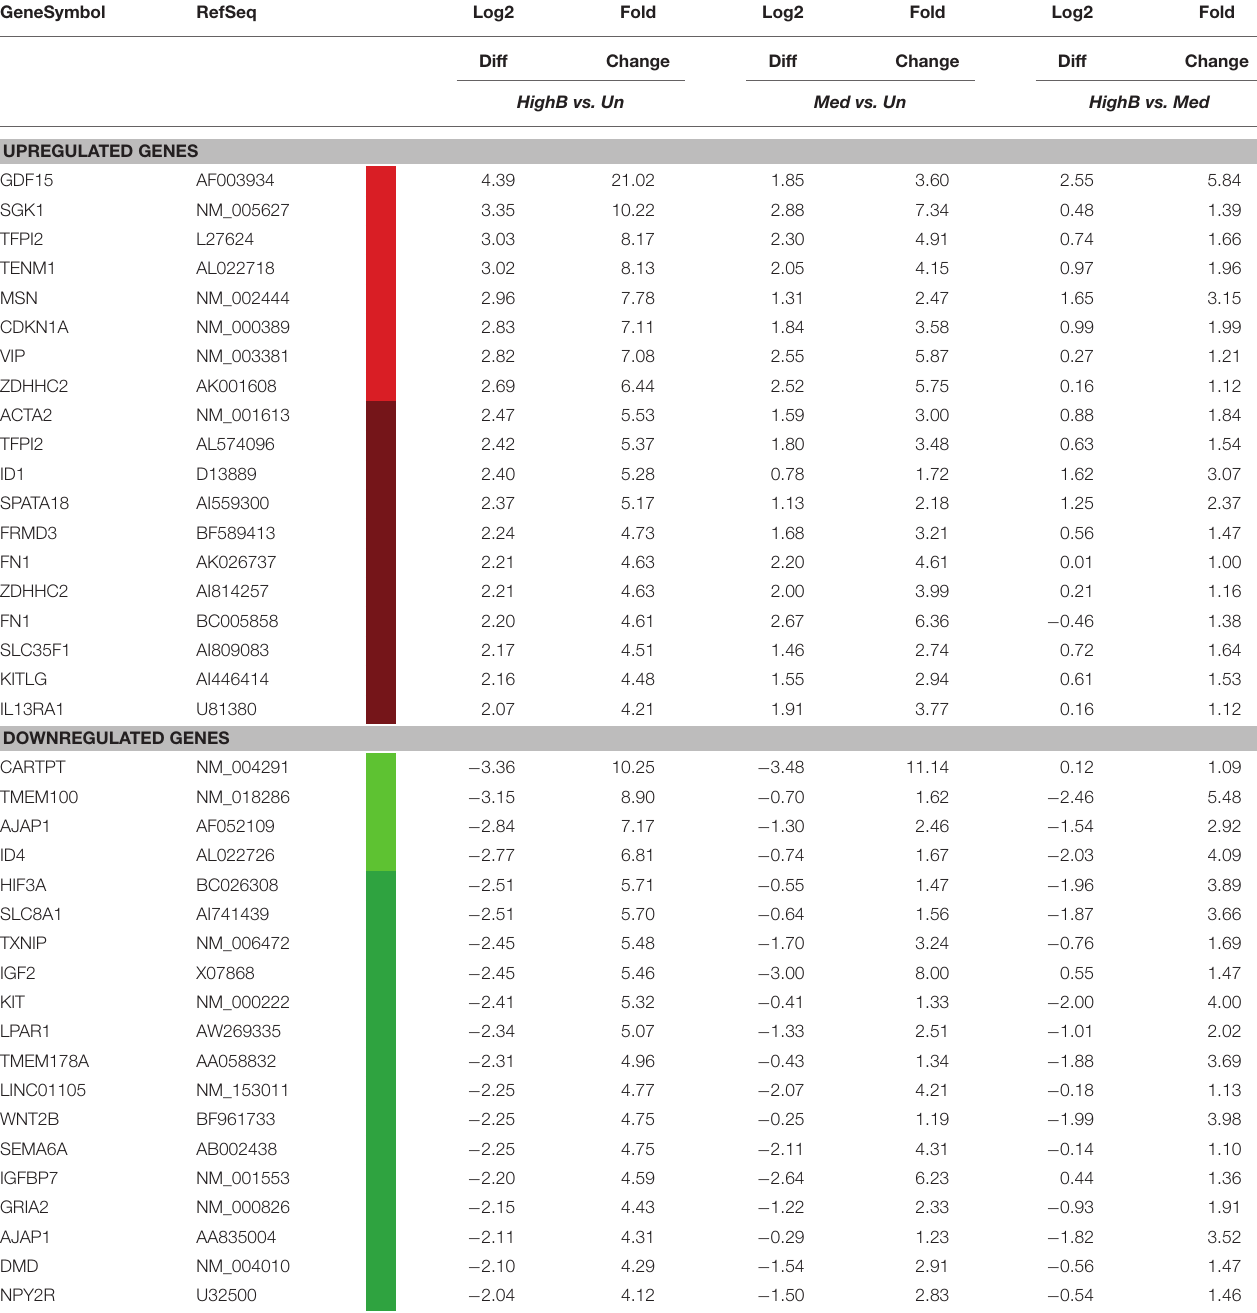
TABLE 4 | Differential Genes expressed by FtMt overexpressing SH-SY5Y neuronal cells.